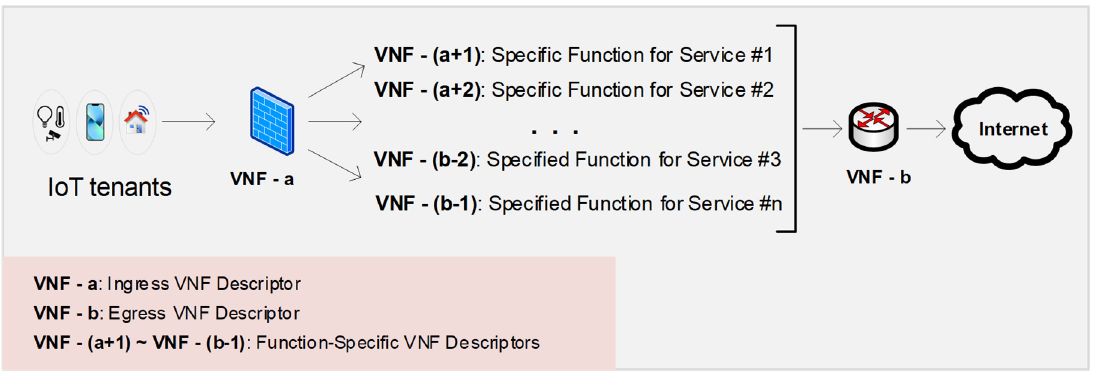
Figure 1. The overview of VNF correlations from ingress to egress VNF